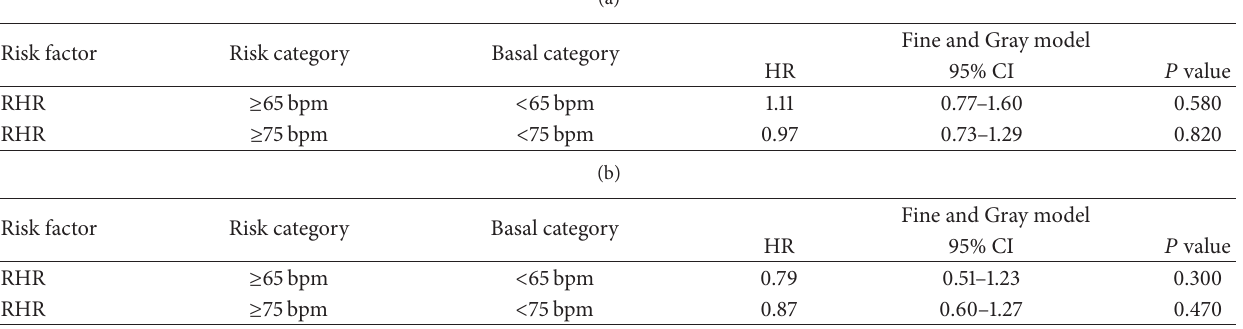
Table 4: (a) Fine and Gray model: the effect of patient and disease characteristics on the progression of DKD (univariate analysis). (b) Fine and Gray model: the effect of patient and disease characteristics on the MACE (univariate